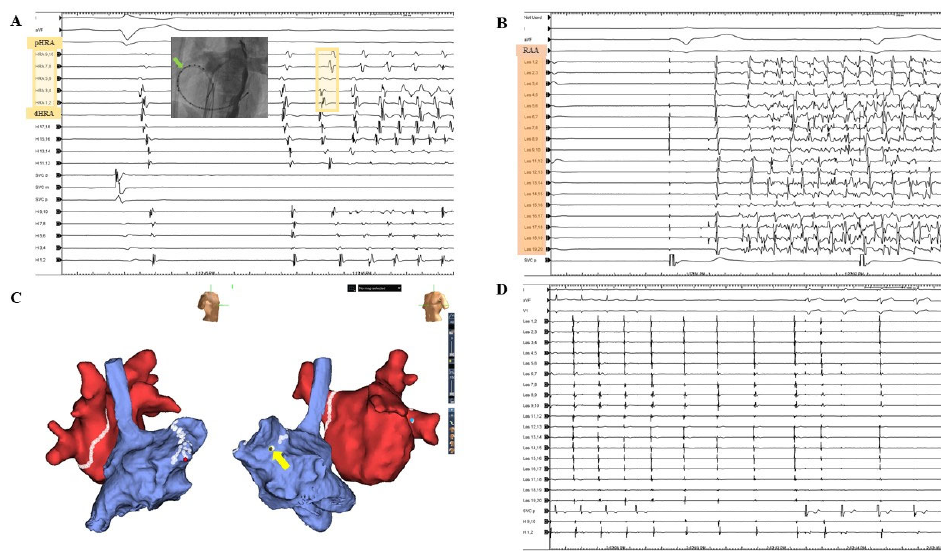
Figure 3. Additional ablation of the trigger site at RAA neck. Adenosine-induced atrial fibrillation (AIAF) originates from the neck of the right atrial appendage (RAA). A 59-year-old man was di- agnosed with paroxysmal AF. Complete pulmonary vein isolation (PVI) was performed, and after confirming inducibility with isoproterenol, 12 mg of adenosine was administered. ( A ) The earliest activation of AIAF was the high right atrium (HRA) near the RAA. The green arrow indicates the earliest HRA 5,6 during AF after adenosine administration. ( B ) After the circular mapping catheter was placed in the RAA, adenosine was administered again to confirm the trigger site for AIAF. The potential of the circular mapping catheter occurred earlier than that of the HRA during AF. ( C ) The triggered site of earliest activation was eliminated until AIAF did not occur. The yellow arrow indicates the termination of the AF. ( D ) AF did not occur even after adenosine administration; therefore, the procedure was